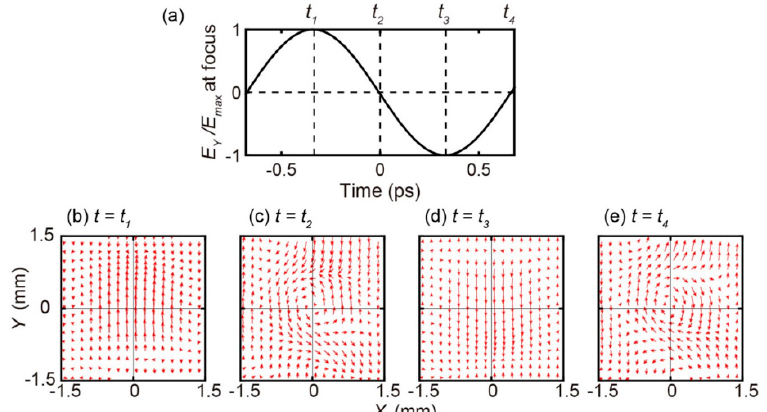
Figure 5. ( a ) Temporal waveform of the terahertz pulse at the focus for the 0.75 THz component. ( b – e ) Experimental results of the spatial distribution of the terahertz E-field vector at different times. For easy comparison, the lengths of the arrows in ( c , e ) are magnified by a factor of 2.5. (Adapted from reference [70]. Copyright (2016), Applied Physics Express.).